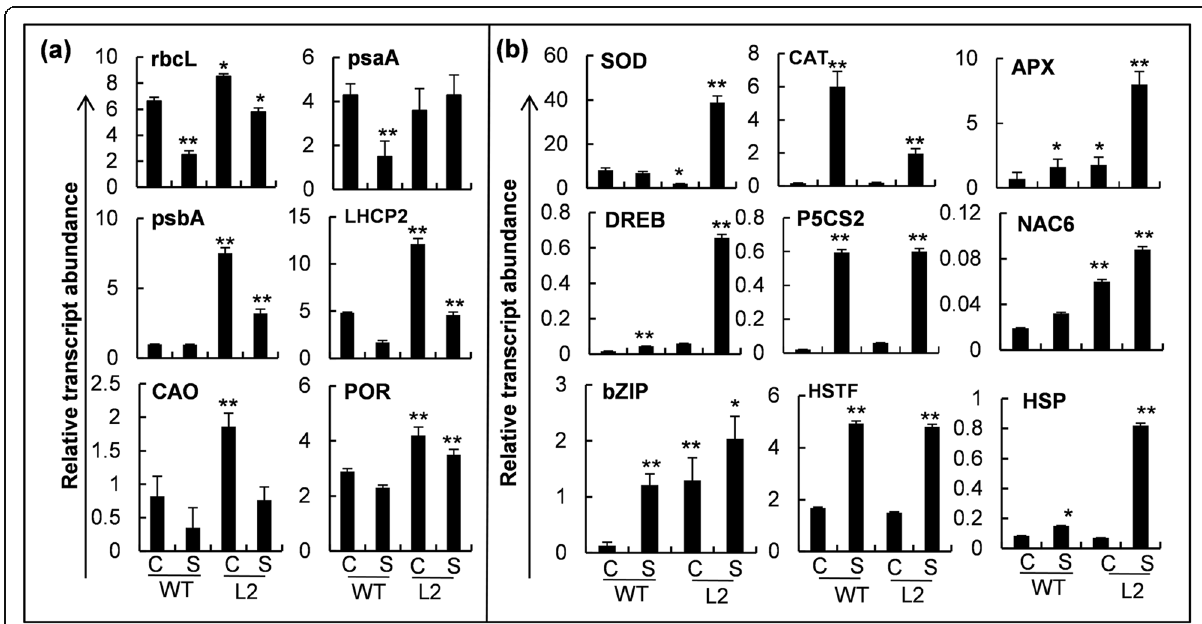
Fig. 6 Transcript abundance analysis for the various photosynthesis and stress-related genes in WT and OsHBP1b over-expressing plants under control and salinity. a Relative expression analysis of selected photosynthesis related genes such as ribulose bisphosphate carboxylase/oxygenase (RbcL ) , Photosystem I P700 chlorophyll a apoprotein A1 (PsaA), Photosystem II P680 chlorophyll a apoprotein A1 (PsbA), Light harvesting complex protein 2 (LHCP2), chlorophyllide a oxygenase (CAO) and P450 oxidoreductase (POR) in WT and OsHBP1b over-expressing plants. b Relative expression analysis of selected stress responsive gens (SOD, superoxide dismutase; APX, ascorbate peroxidise; CAT, catalase; bZIP, leucine zipper transcription factor; HSTF, heat shock transcription factor; HSP, heat shock protein; MT, metallothionine; DREB, dehydration responsive element binding protein; NAC TF, NAC domain containing transcription factors; P5CS, 2-pyrroline-5-carboxylate synthetase-2) in WT and OsHBP1b over- expressing plants. Expression analysis was done by quantitative real time PCR method. Expression of eEF gene was taken as reference and transcript abundance was calculated using 2 - Δ CT method. Error bars show standard error from triplicate experiments. Single asterisk show significant difference at p < 0.005 and double asterisk at p <